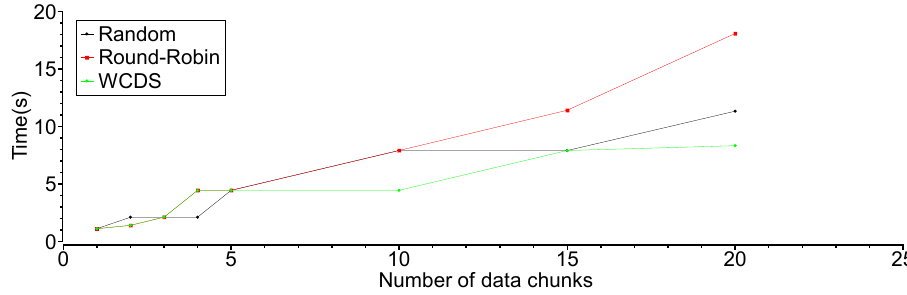
Figure 7. Data Transfer Completion Time under Different Scheduling Strategies.